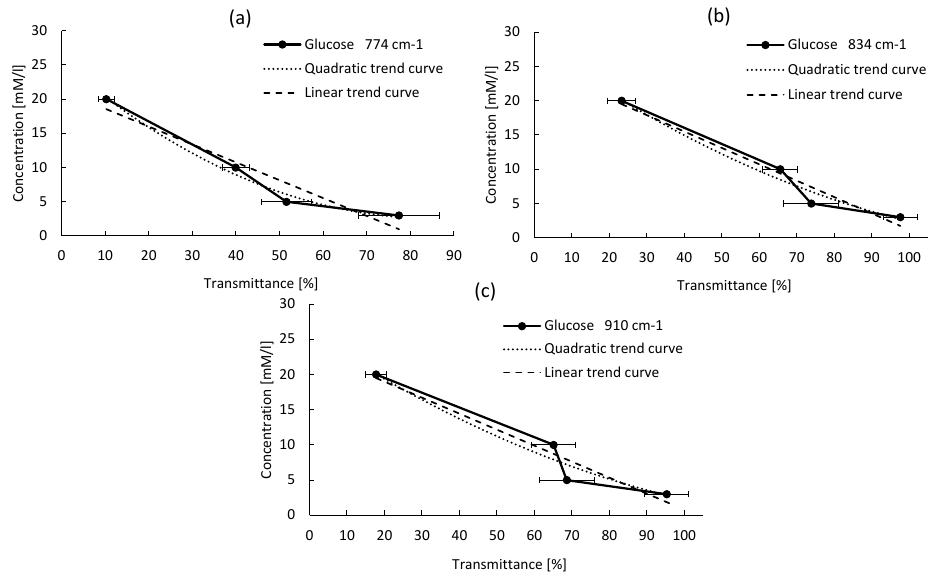
Figure 10. Glucose absorption intensity versus its concentration for different peaks, for the absorption peaks at ( a ) 774 cm − 1 , ( b ) 834 cm − 1 , ( c ) 910 cm − 1